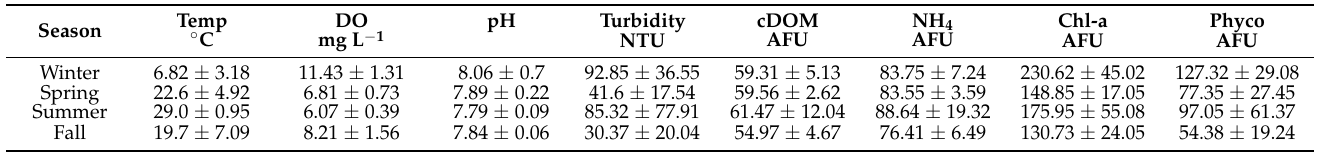
Table 1. Average concentration of water measurements across seasons with ( ± standard deviation). Turbidity measured in NTU (Nephelometric Turbidity Units) cDOM, NH 4 , Chl-a, and Phycocyanin measured in AFU (Arbitrary Fluorescence Units).